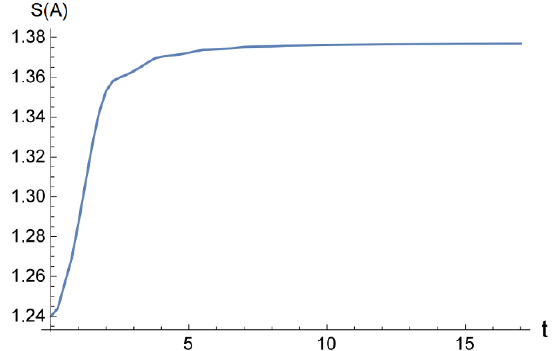
Figure 14. The entanglement entropy of a region grows with time and approaches an equilibrium. In the plot, the size of the total system is L = 202, and the size of the subsystem is j A j = 6. Fermion mass m = 1 = 100.